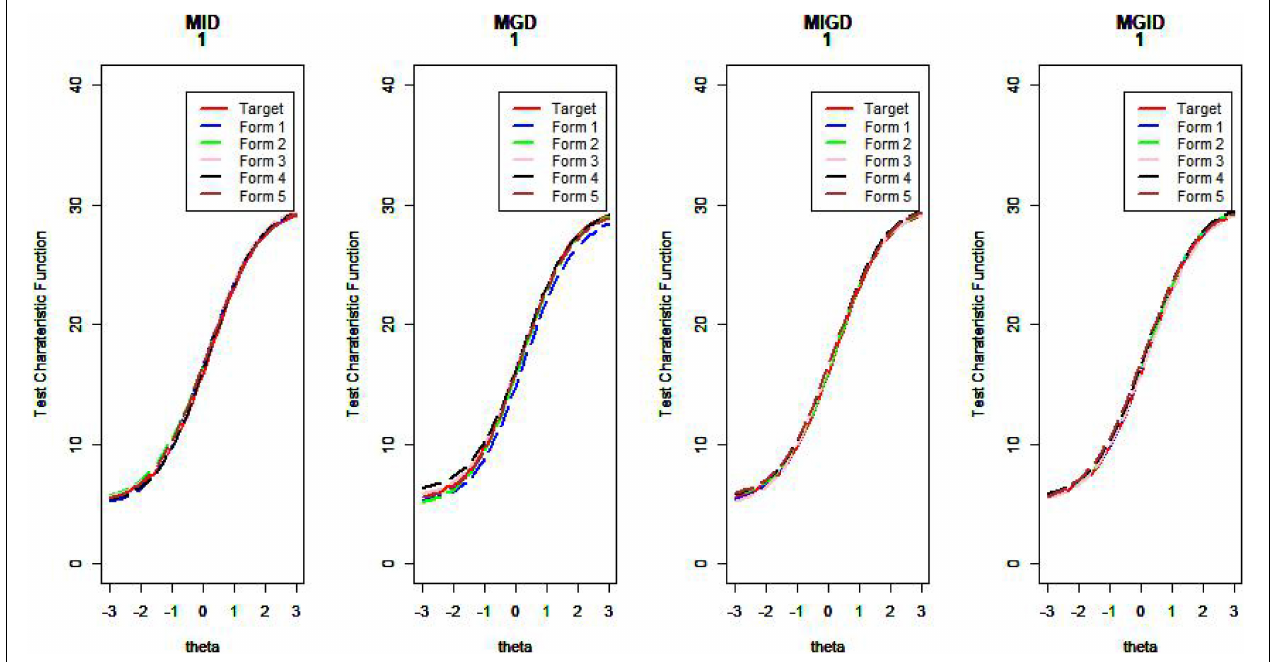
FIGURE 15 | Test characteristic curve ( D = 1).